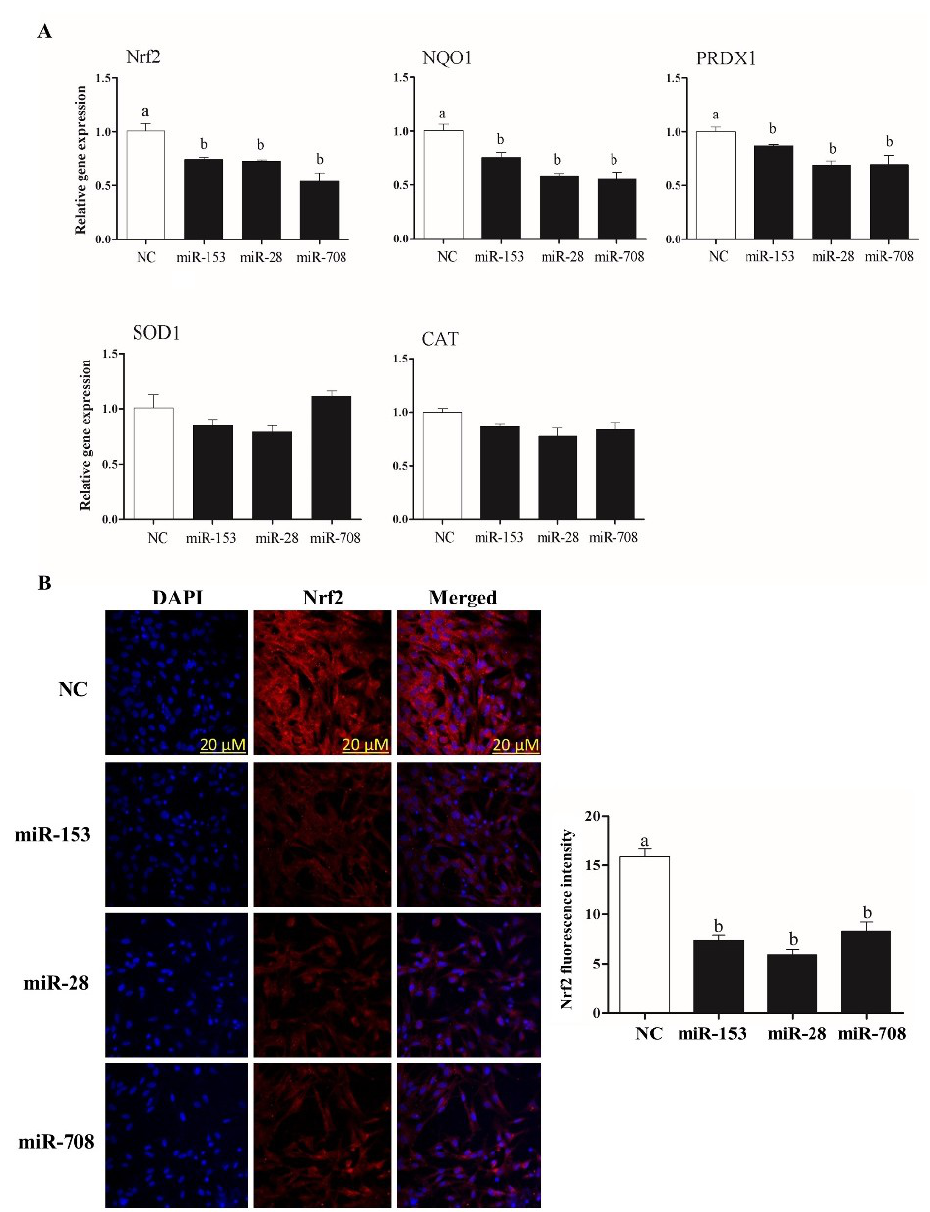
Figure 2. Quantitative RT-PCR of Nrf2 and its downstream antioxidants in bovine granulosa cells co-transfected with miR-153, miR-28 and miR-708 mimics ( A ). Immunocytochemistry of Nrf2 in bovine granulosa cells co-transfected with miR-153, miR-28 and miR-708 mimics ( B ). Data are presented as mean ± SEM of three independent biological replicates. Bars with different letters (a,b) showed statistically significant differences ( p ˂ 0.05).